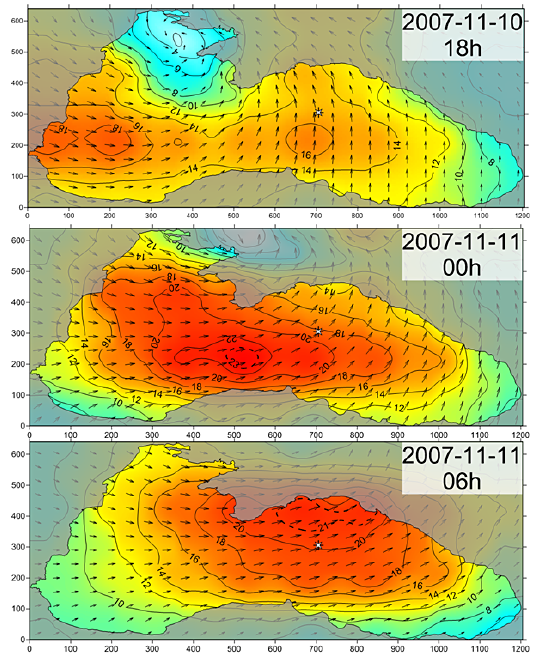
Figure 15. Wind speed [ms − 1 ] and direction during the storm event in November 2007. The three locations of maximal calculated SWH during the storm are indicated by